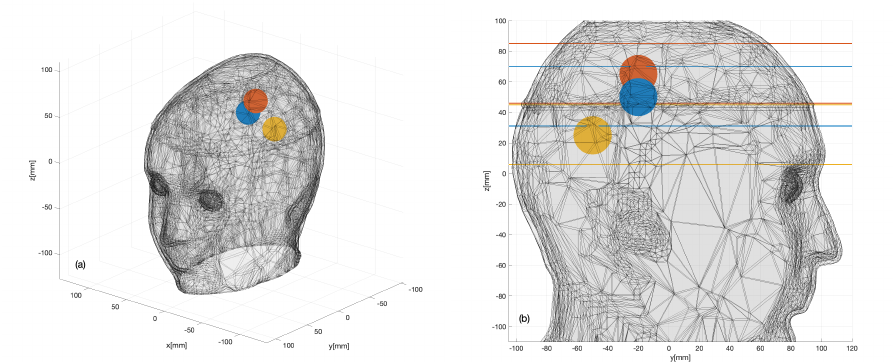
Figure 7. Three sphere locations (color dots) considered within the 3D head phantom: ( a ) 3D view; ( b ) 2D sagittal